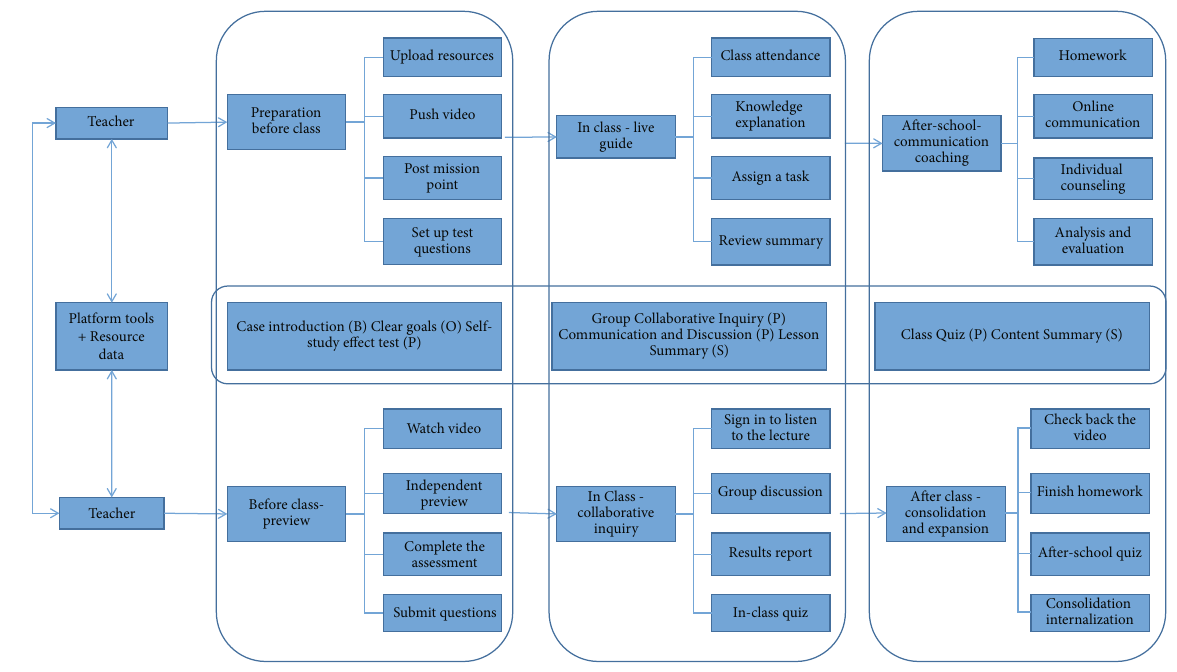
Figure 11: Online mixed multiple teaching mode based on BOPPPS model. Table 2: Application of BOPPPS model in college English audiovisual courses.